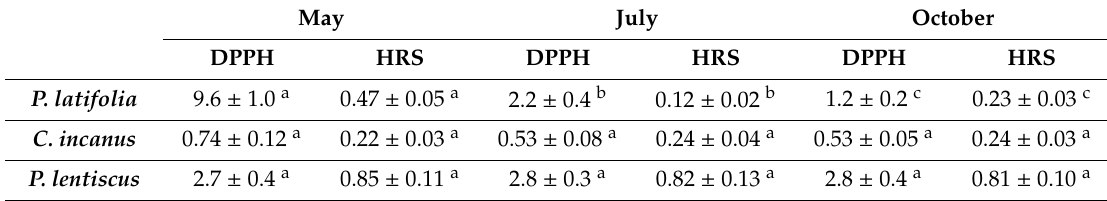
Table 2. Antioxidant capacity (EC 50 values, in µ g mL − 1 ) of Phillyrea latifolia , Cistus incanus and Pistacia lentiscus extracts from leaves harvested at 13.00, during the three di ff erent months (May, July